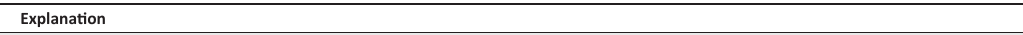
TABLE 12: Key terms. Term Explanation